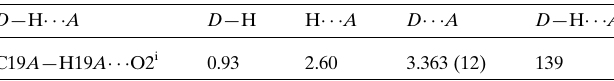
Table 1 Hydrogen-bond geometry (A˚ , (cid:3) ).